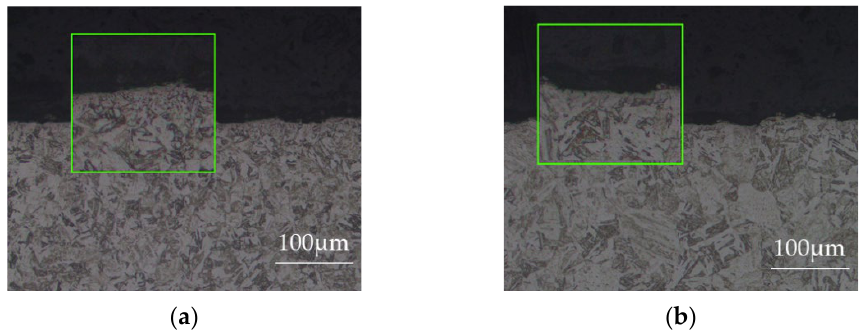
Figure 7. Microstructural analysis: ( a ) untextured sample; ( b ) Ed = 35.37 J/cm 2 and Vs = 10 mm/s sample.